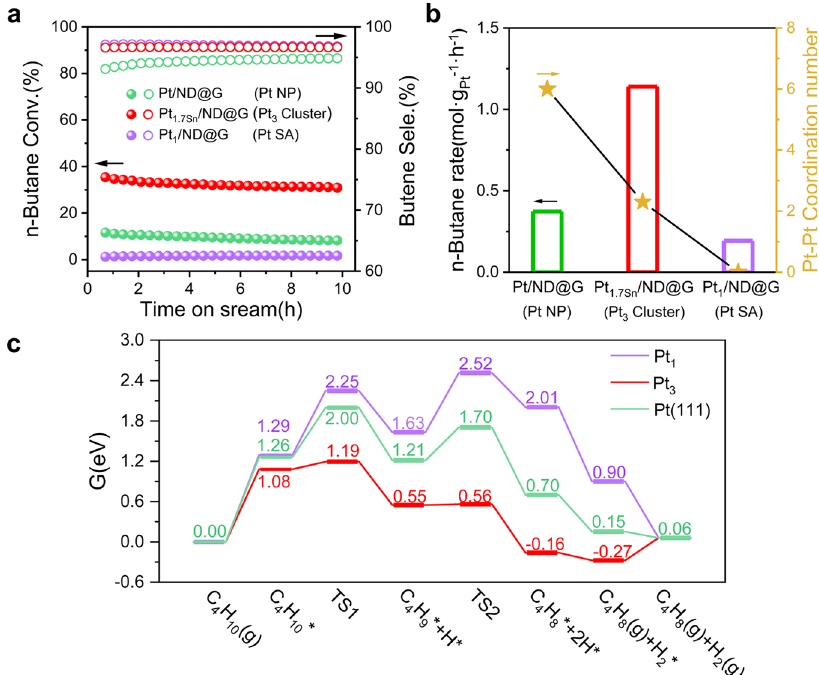
Fig. 4 Catalytic performance for n-butane DDH. a n-butane conversion and butene selectivity by time-on-stream during n-butane DDH at 450 °C, GHSV = 18000 mL ⋅ g cat − 1 ⋅ h − 1 , n-C 4 H 10 :H 2 = 1:1 with He balance. b the conversion rate of n-butane in the n-butane DDH and Pt – Pt CN. c energy pro fi le of butane dehydrogenation to 2-butene on the Pt 1 -Gr, Pt 3 -Gr, and Pt (111). (purple: Pt 1 -Gr, red: Pt 3 -Gr, green: Pt cluster doped into single-vacancy graphene (Pt 3 -Gr) were used to C 4 H 8 (2-C 4 H 8 * ) is generated via the further dehydrogenation of model Pt/ND@G, Pt 1 /ND@G, and Pt 1.7Sn /ND@G, respectively. 2-C 4 H 9 * ; (iv) the desorption of 2-C 4 H 8 * to form the product 2- The dehydrogenation process follows four steps: (i) the adsorp- butene gas. Supplementary Tables 4 – 6 summarize the reaction tion of n-butane; (ii) the dehydrogenation of n-butane to surface energy and barriers of butane dehydrogenation for Pt 1 -Gr, Pt 3 - adsorbed 2-C 4 H 9 species (2-C 4 H 9 * ); (iii) the surface adsorbed 2- Gr, and Pt (111). The Gibbs free energy pro fi le of butane